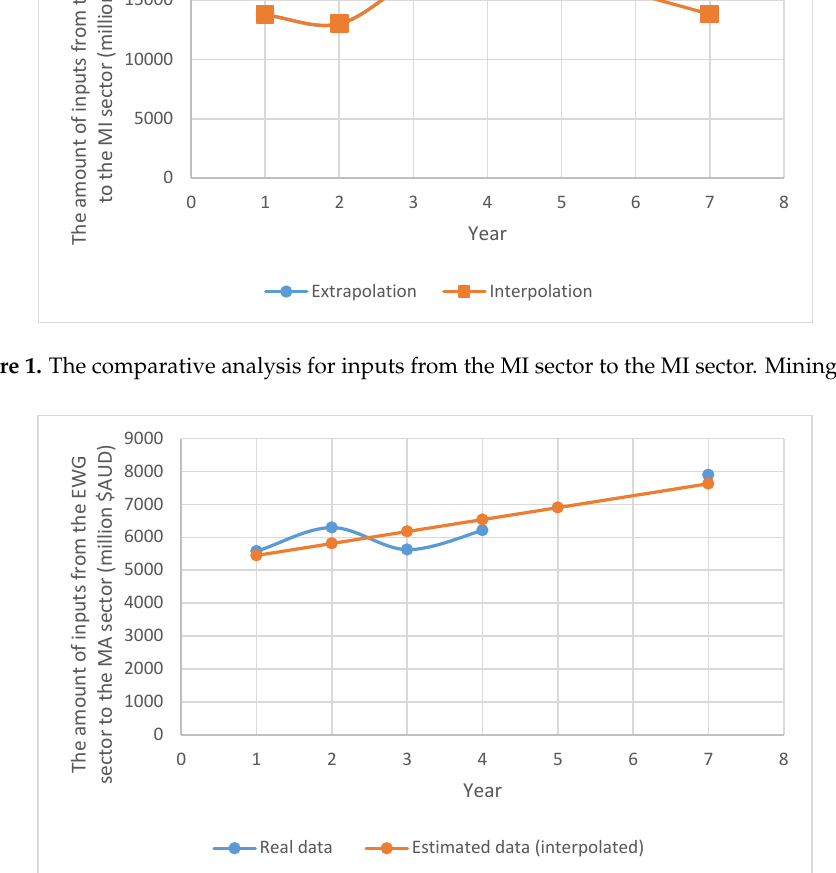
Figure 2. Inputs from the EWG sector to the MA sector (linear regression equation). Electricity, gas, and water = EGW; Manufacturing = MA. Recycling 2017 , 2 , 12